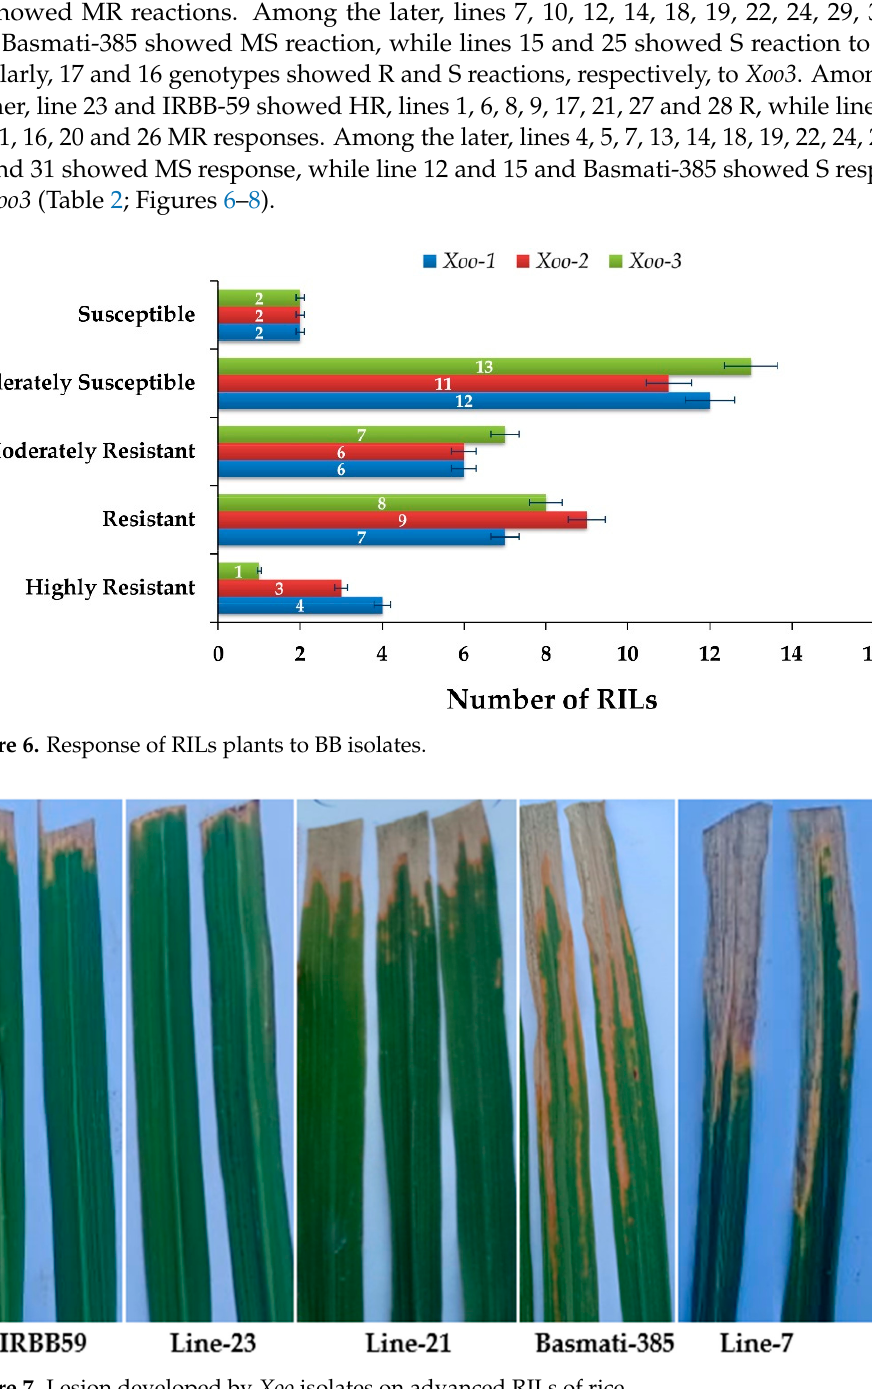
Figure 8. Bar graph showing diseases incidence (%). Vertical bars denote ± SE.